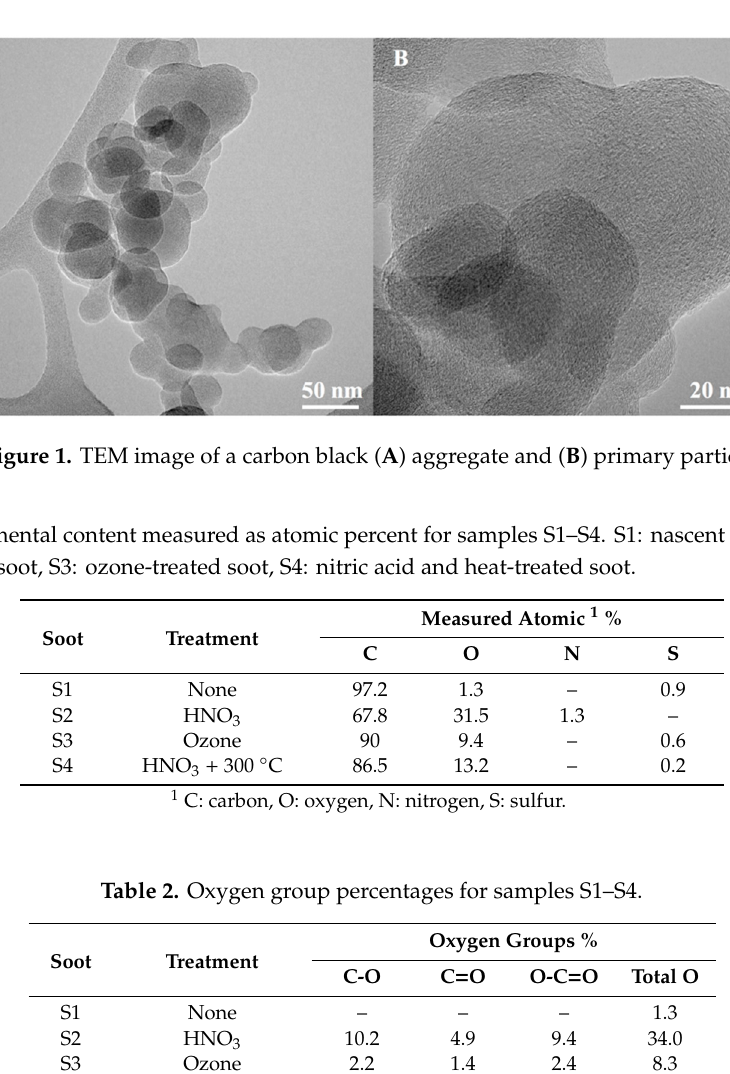
Table 1. Elemental content measured as atomic percent for samples S1–S4. S1: nascent soot, S2: nitric acid-treated soot, S3: ozone-treated soot, S4: nitric acid and heat-treated soot. Soot